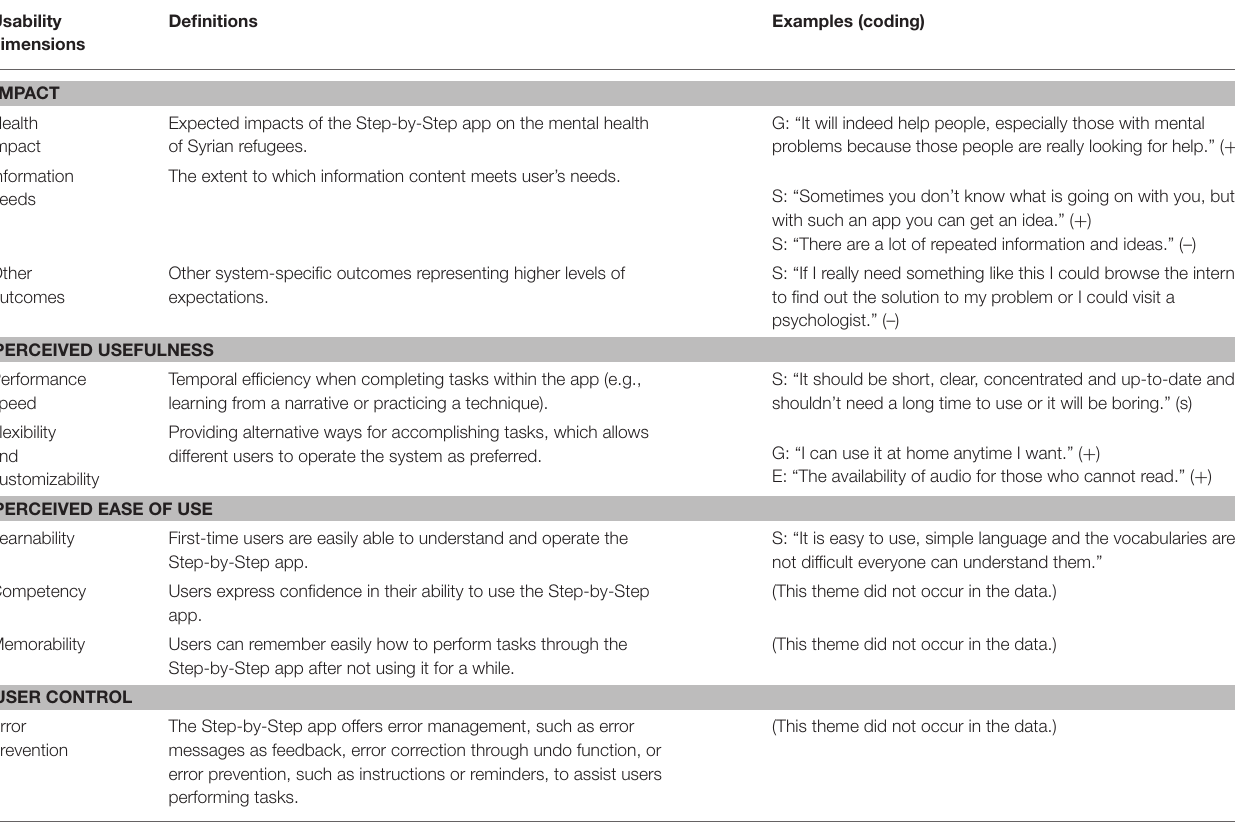
TABLE 1 | Definitions of the Health-ITUEM usability dimensions used for deductive data analysis (adapted based on (49, 51), and